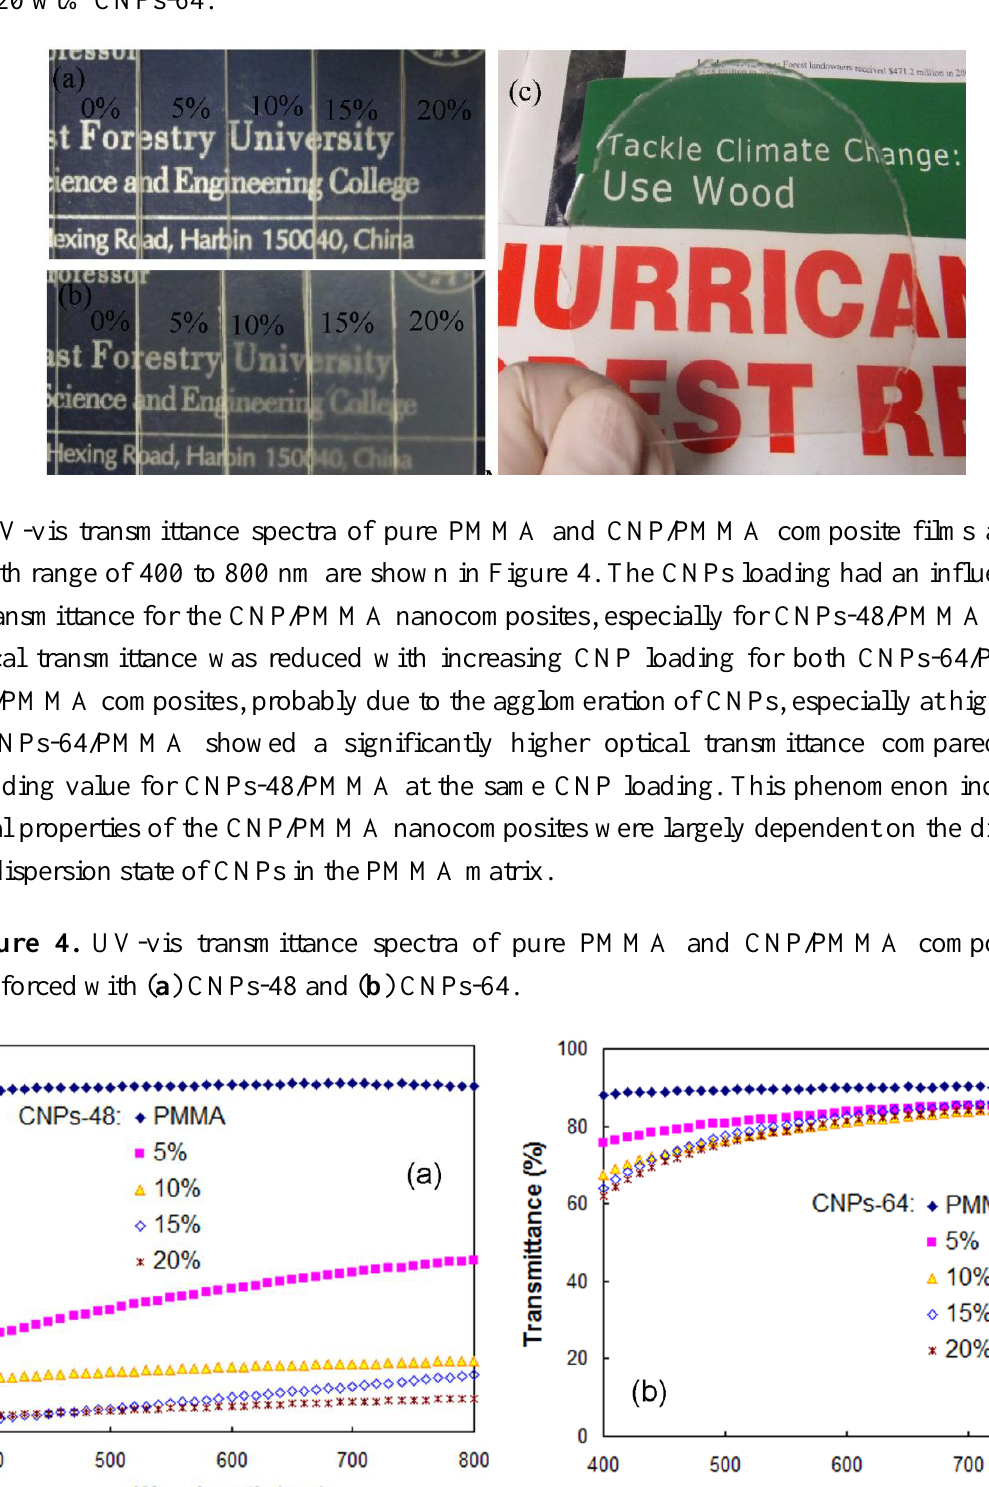
Figure 3. Photographs of pure PMMA and CNP/PMMA composite films placed on a background paper ( a : CNPs-64, b : CNPs-48), and the CNP/PMMA composite film with ( c ) 20 wt% CNPs-64.